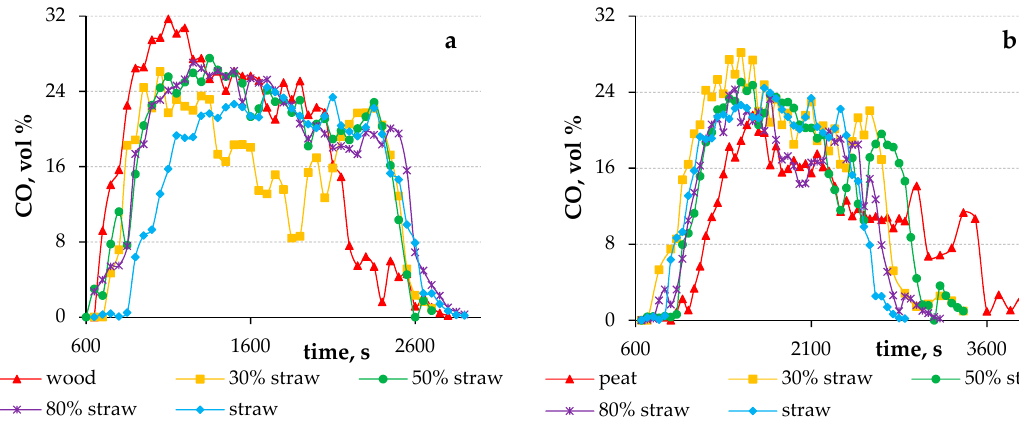
Figure 3. Effect of the wheat straw share wt.% in a mixture with wood ( a ) and with peat ( b ) pellets on the CO formation kinetics in the gasifier (FTIR).